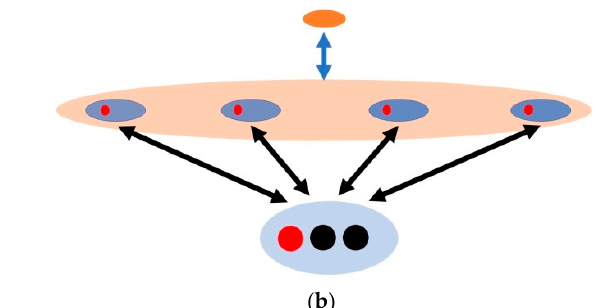
Figure 4. The representation of inclusion relations:( a ) in repeated addition ( b ) in multiplication (The diagram is reimagined based on [18] and [19]).